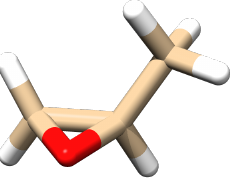
Figure 9. Representation of the equilibrium structure of ( R )-methyloxirane computed by DFT at the B3LYP/aug-cc-pVQZ level of